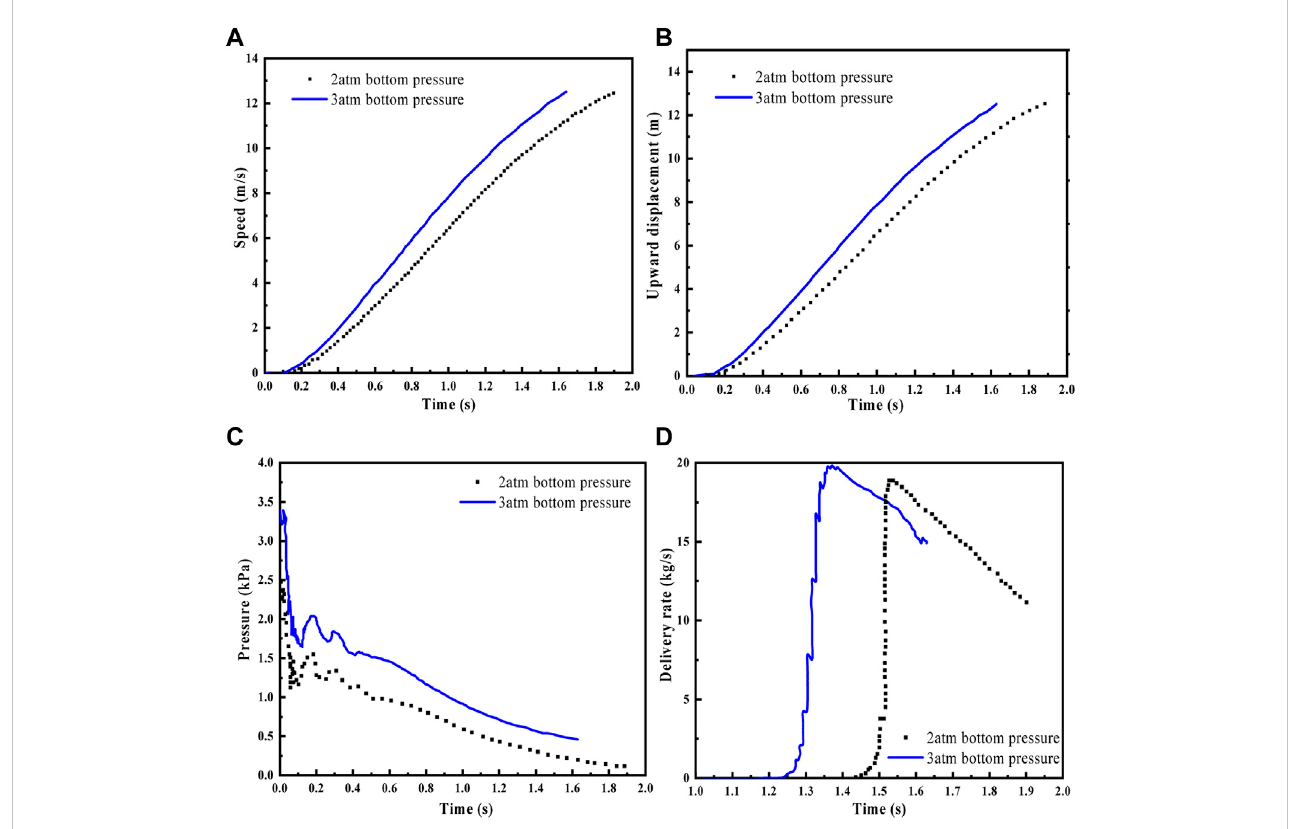
FIGURE 9 Analysis of simulation results. (A) . Plunger ’ s upward speed. (B) . Plunger ’ s upward displacement. (C) . Bottom-hole pressure change. (D) . Wellhead liquid fl ow rate.